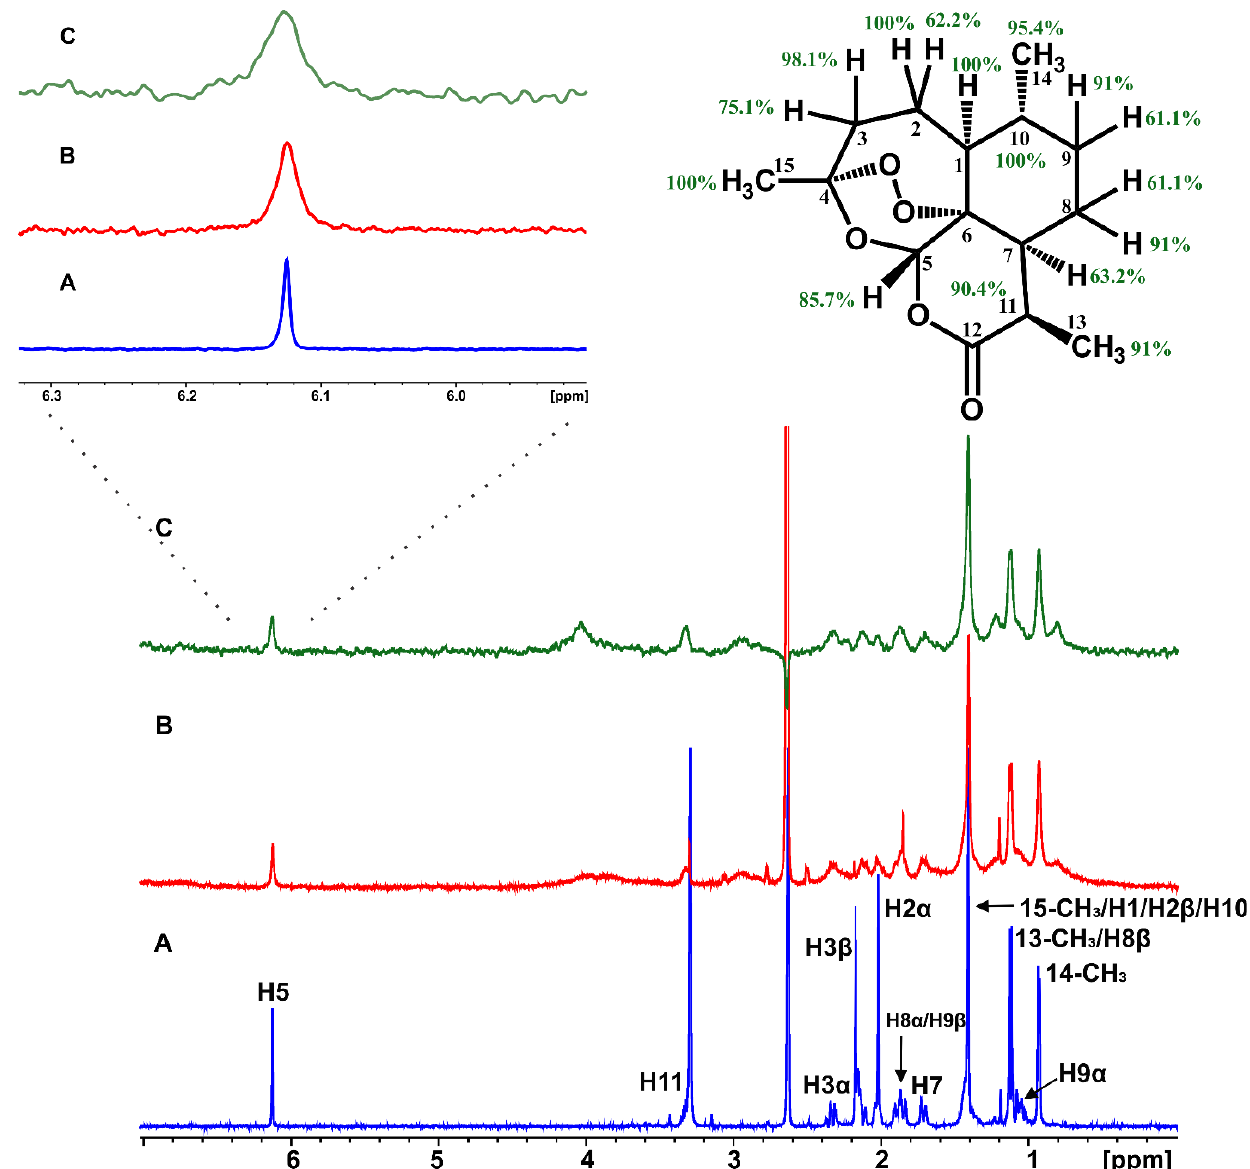
Figure 1. (A) 1 H NMR of 2 mM artemisinin in PBS, pD 7.4, D 2 O with 10% DMSO-d 6 . (B) 1 H NMR of Figure 1. ( A ) 1 H NMR of 2 mM artemisinin in PBS, pD 7.4, D 2 O with 10% DMSO-d 6 . ( B ) 1 H NMR of 2 mM artemisinin with 20 μM BSA in PBS, pD 7.4, D 2 O with 10% DMSO-d 6 . (C) STD NMR of 2 mM 2 mM artemisinin with 20 µ M BSA in PBS, pD 7.4, D 2 O with 10% DMSO-d 6 . ( C ) STD NMR of 2 mM artemisinin with 20 μM BSA. Τ = 310 K, number of scans = 320, experimental time = 3 h 30 min. artemisinin with 20 µ M BSA. T = 310 K, number of scans = 320, experimental time = 3 h 30